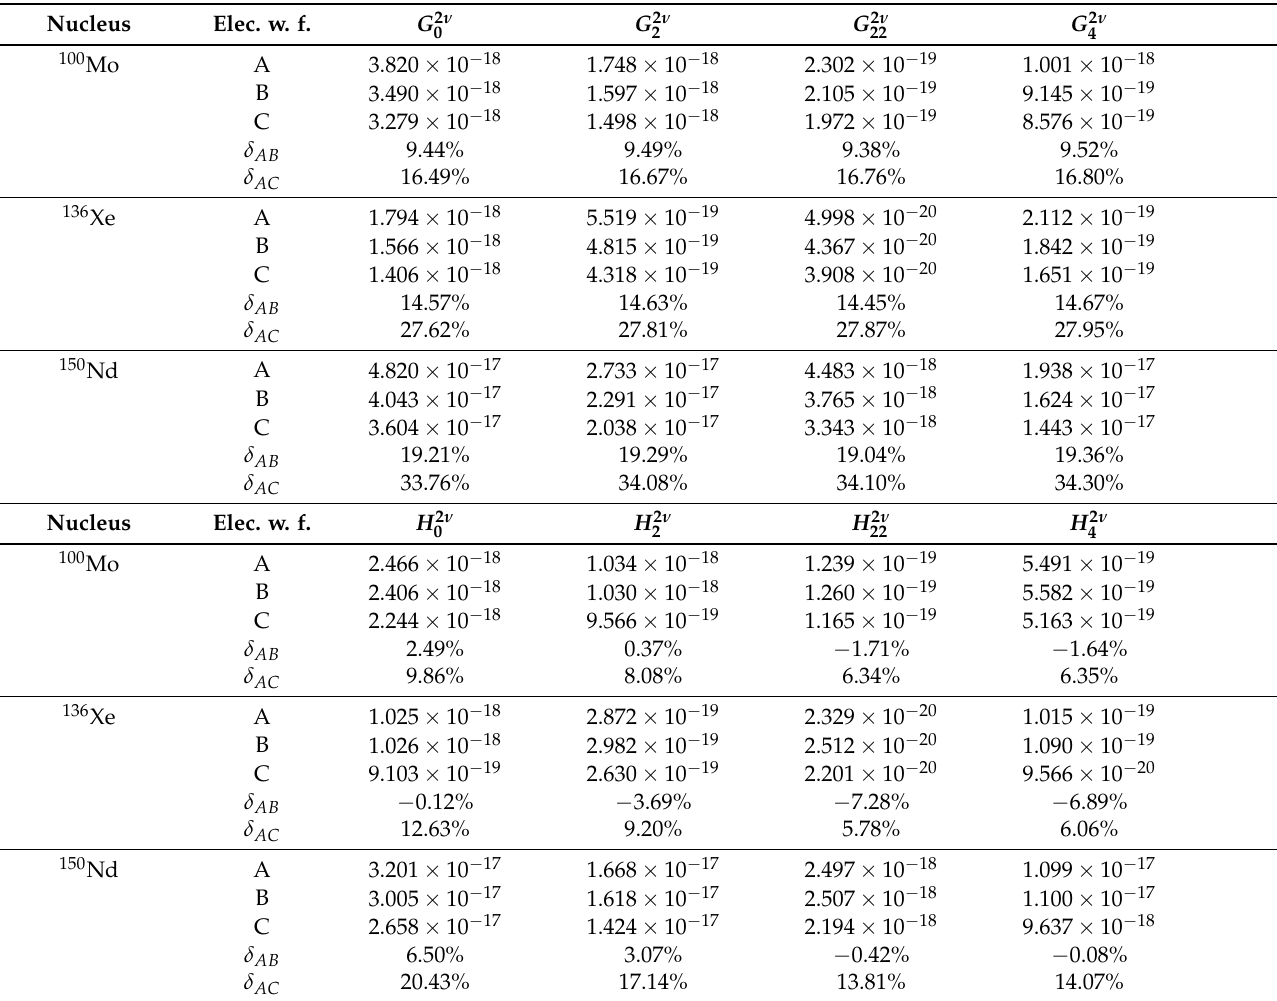
Table 1. Phase space factors G 2 ν and H 2 ν with N = { 0,2, 22,4 } for 2 νββ decay of 100 Mo, 136 Xe and 150 Nd. The results are N N obtained using different approximations for the radial wave functions g − 1 ( E e ) and f 1 ( E e ) of the electron: (A) The standard approximation of Doi et al. [28]. (B) The analytical solution of the Dirac equation for a point-like nucleus [29]. (C) The exact solution of the Dirac equation for a uniform charge distribution of the nucleus screened by the atomic electronic cloud. The results are presented in yr − 1 . For each nucleus and each phase space factor we present the percent deviation between approximation schemes A and B, δ AB = 100 ( X A − X B ) / X B , and the percent deviation between approximation schemes A and C, δ AB = 100 ( X A − X C ) / X C , with X = G 2 ν or X = H 2 ν N N